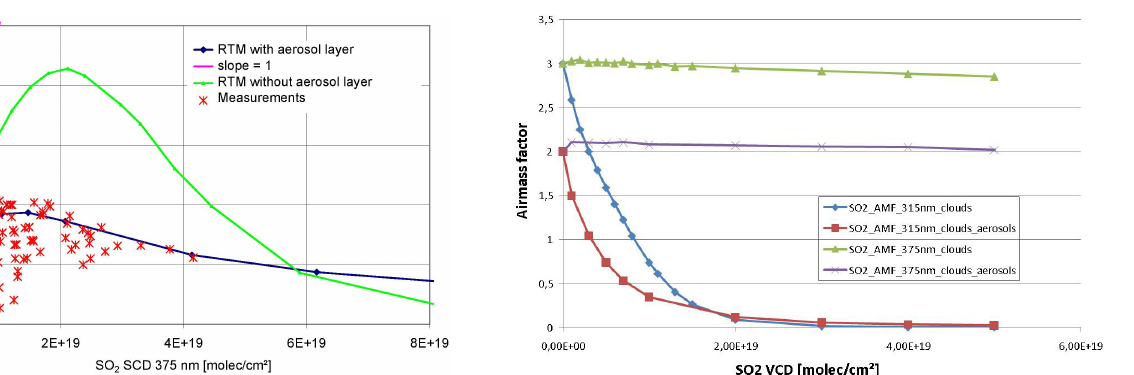
Fig. 7. AMF dependency on the SO 2 VCD, wavelength and aerosols. While the AMF for the short wave UV range rapidly de- crease for large SO 2 VCDs, it almost remains constant for the long wave UV range. In the presence of aerosols, the reduced sensitivity is less pronounced for very high SO 2 loads ( > 2 × 10 19 mol/cm 2 ), because more light is scattered back by the aerosol particles to the satellite instrument from the layer of enhanced SO 2